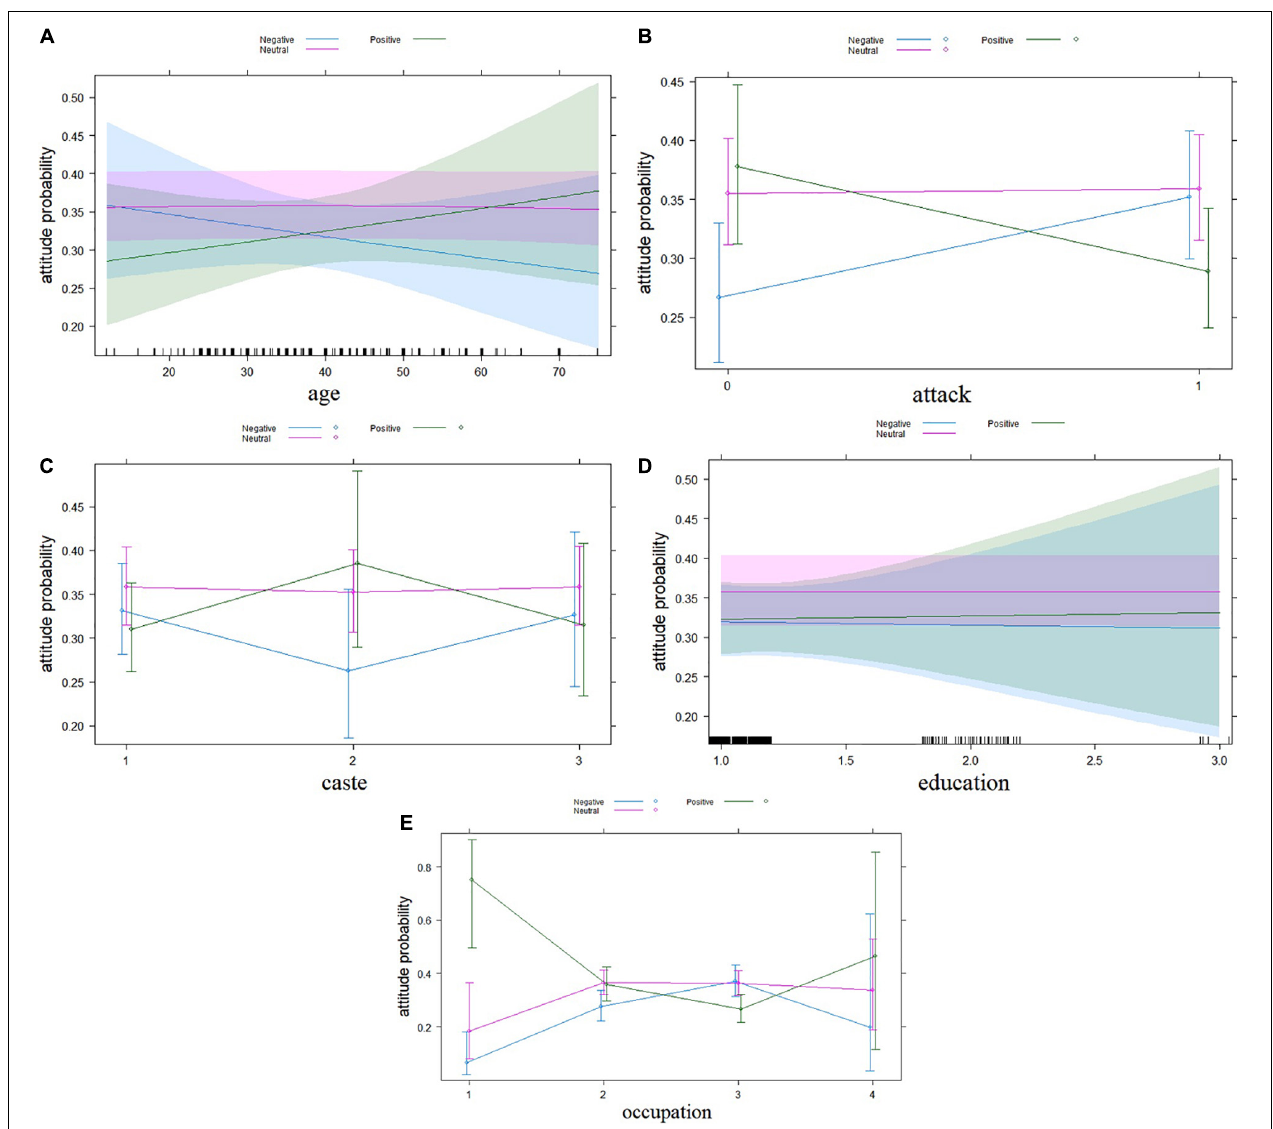
FIGURE 4 | Probability of attitude responses in ordinal models for predicting attitudes toward wolves. (A) Effect of Age. (B) Effect of livestock attacked by wolves (0 = No attack, 1 = attack). (C) Effect of caste (1 = Gurjar, 2 = Meena, 3 = Others). (D) Effect of Education (1 = 5th and below, 2 = 6th-10th standard, 3 = 10th and above. (E) Effect of Occupation (1 = Laborer, 2 = Farmer, 3 = Shepherd, 4 =